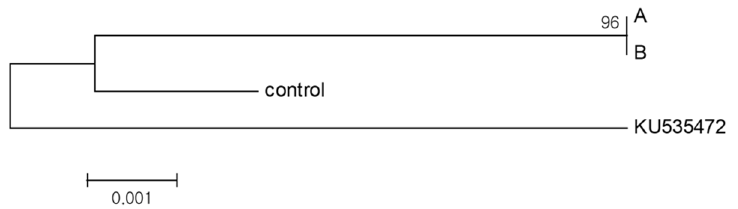
Figure 7. Maximum likelihood phylogenetic tree of anther culture-derived regenerated plants based on nucleotide sequences in the internal transcribed spacer (ITS; ITS1 + 5.8S rDNA + ITS2) region. A and B: regenerated plants obtained through anther culture; control: donor and heterozygous plants; Ku535472: accession number of “sour orange” registered in the GenBank.